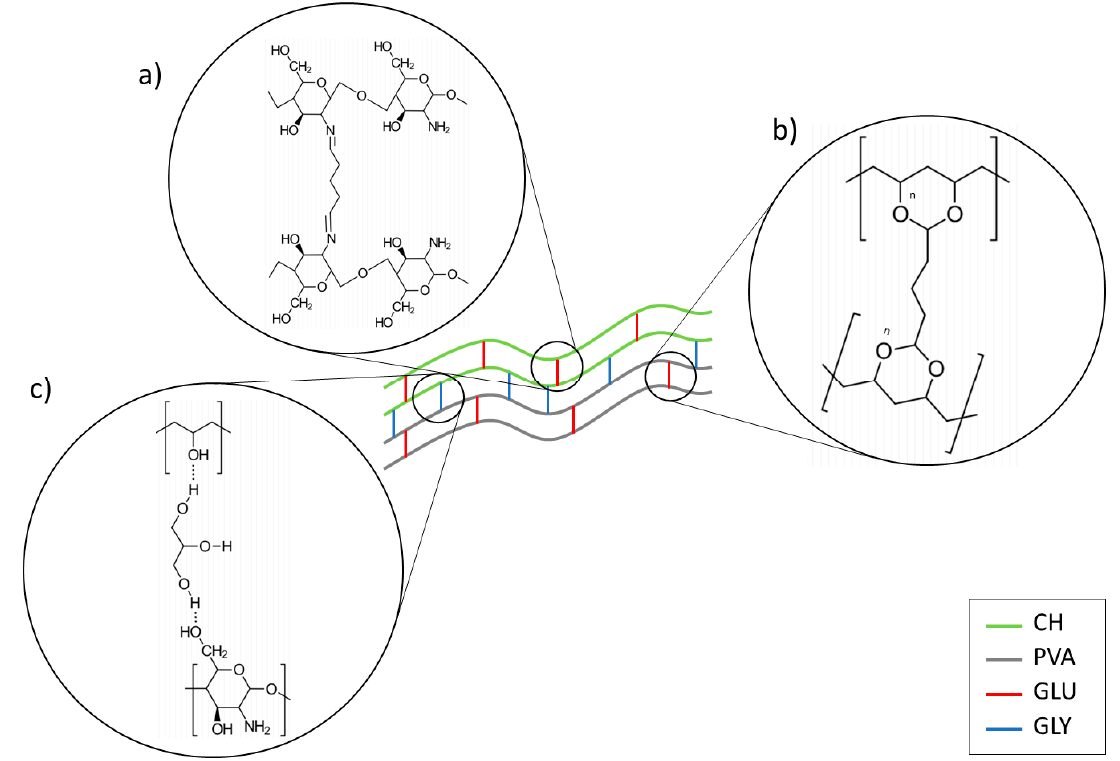
Figure 1. Schematic representation of interactions between CH, PVA, GLU, and GLY. ( a ) CH crosslinked by GLU. ( b ) PVA crosslinked by GLU. ( c ) Hydrogen bonding between CH and PVA with GLY.